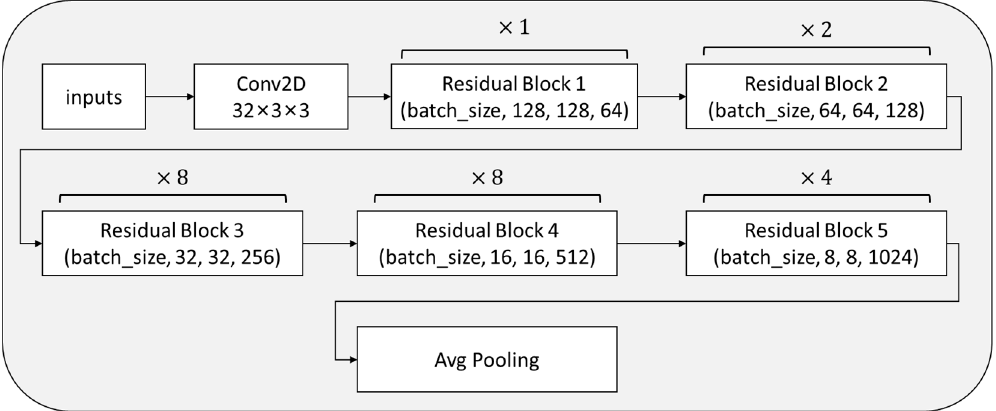
Figure 13. Structure of feature extraction module.